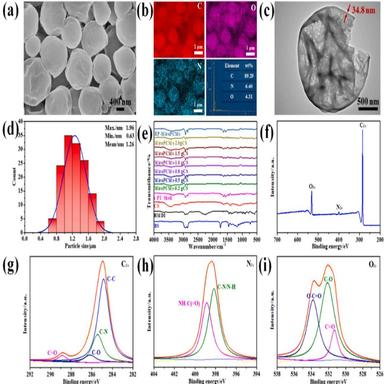
(a) FE-SEM images of RP-MicroPCMs; (b) EDX spectrum of RP-MicroPCMs; (c) TEM images of RP-MicroPCMs; (d) particle size distribution of RP-MicroPCMs; (e)FT-IR spectra of MicroPCMs with various mass fraction of CS; (f)full-scale XPS images of RP-MicroPCMs; (g, h, i) high resolution XPS spectra of C1s, N1s, and O1s, respectively.